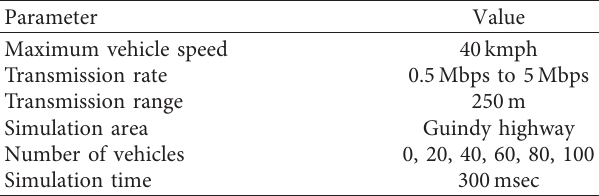
Table 1: Simulation setting for the proposed TAD-HOC